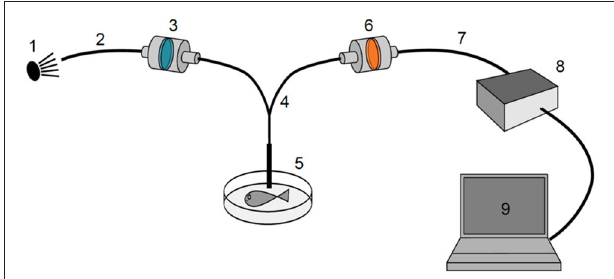
FIGURE 4 | General spectrometry setup. A near-monochromatic green excitation light source (1) was connected (2) via a short-pass or clean-up filter (3) to a bifurcated fiber optics cable (4) that terminated in a hand-held probe (5) close to the measured fish. The emitted light was redirected through a long-pass filter (6–7), analyzed by a high-sensitivity Ocean Optics QE65000 spectrometer (8) and visualized using Ocean Optics SpectraSuite software (9).